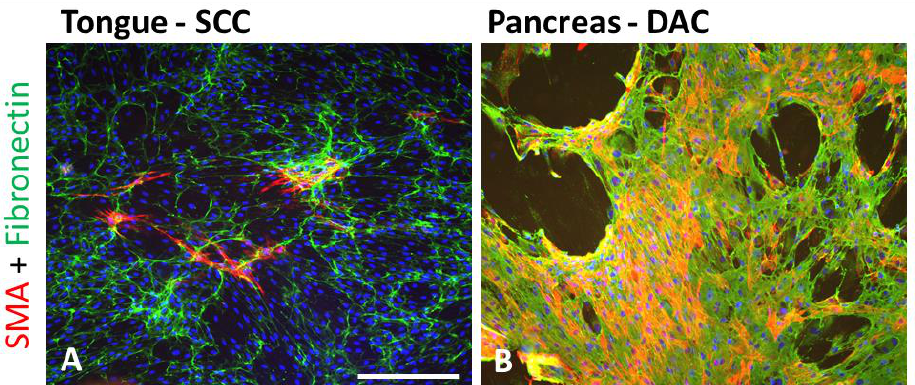
Figure 2. CAFs isolated from squamous cell carcinoma (SCC) of the tongue ( A ) and ductal adenocarcinoma (DAC) ( B ) of the pancreas (desmoplastic form) express SMA (red) and produce fibronectin (green). Bar represents 100 µ m.